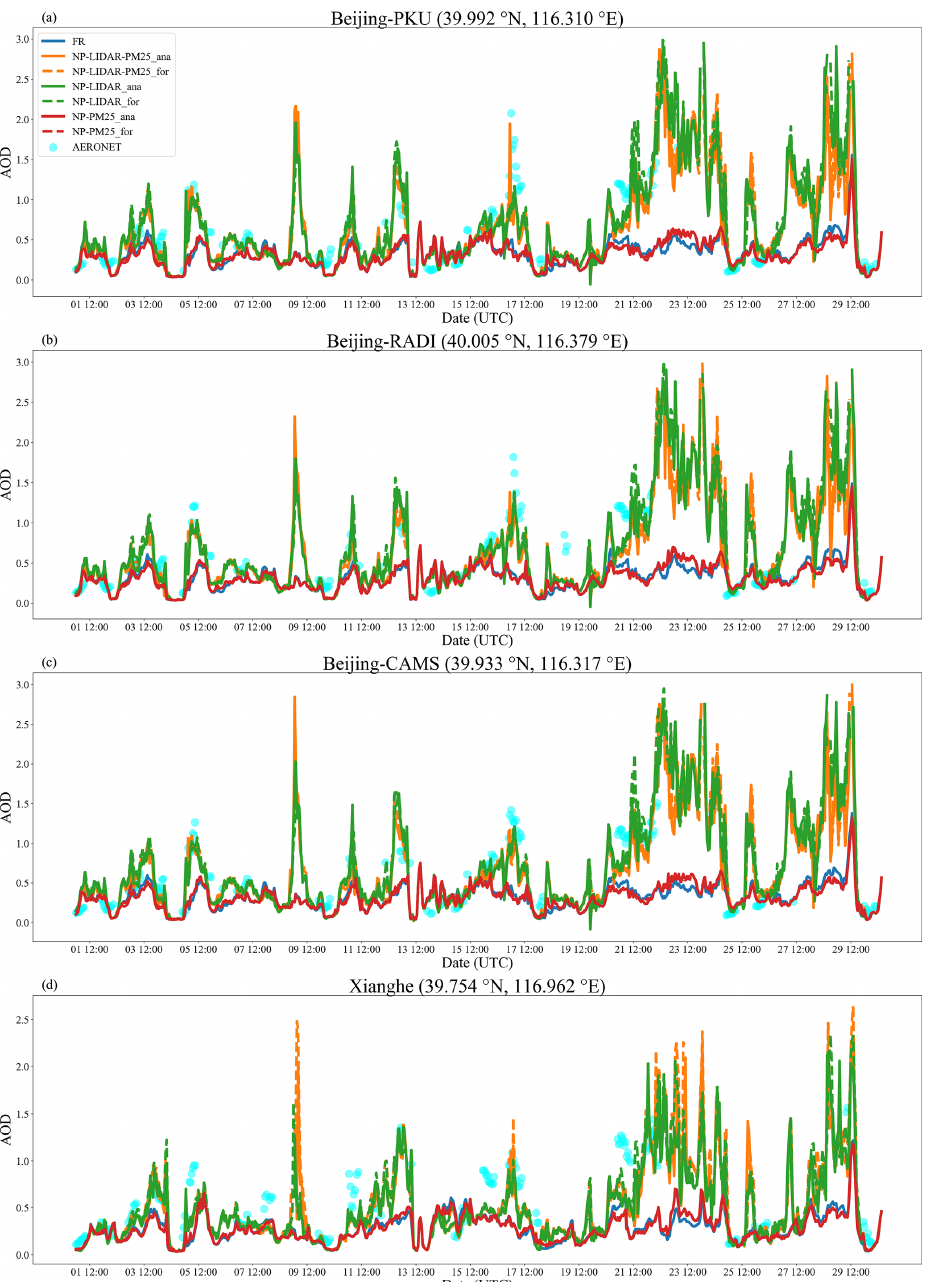
Figure 13. Hourly time series of AOD measured by AERONET and in the analysis and forecast of the FR, NP-PM25, NP-LIDAR, and NP-LIDAR-PM25 experiments at the AERONET sites Beijing-PKU (a) , Beijing-RADI (Institute of Remote Sensing and Digital Earth) (b) , Beijing-CAMS (Chinese Academy of Meteorological Sciences) (c) , and Xianghe (d)